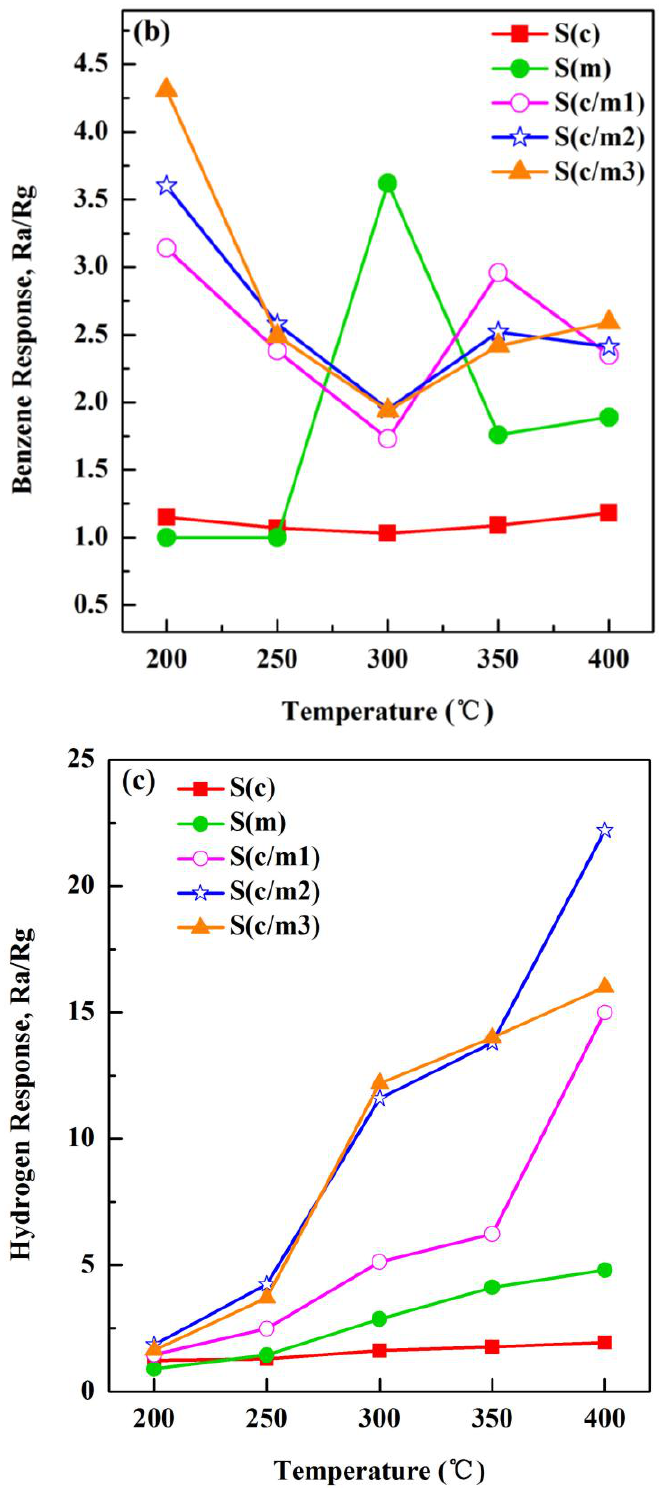
Figure 12. Temperature dependence of the responses of the gas sensors: ( a ) ethanol at 10 ppm; ( b ) benzene at 10 ppm; and ( c ) hydrogen at 1000 ppm.